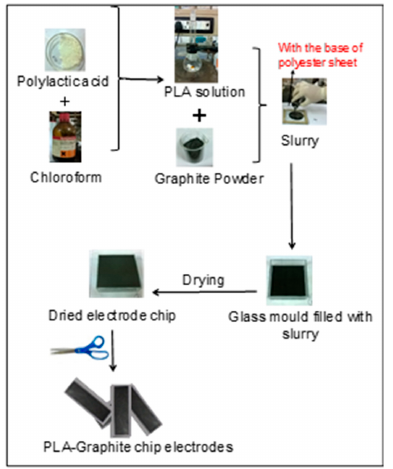
Figure 1. Preparation method of PLA-Graphite composites.